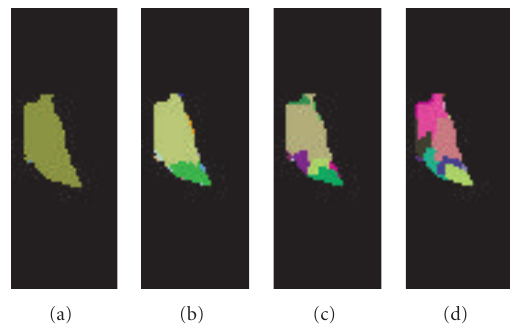
Figure 4: The histological atlas of the human thalamus with nuclei outlined by black lines (Image courtesy of Behrens et al. [3]).